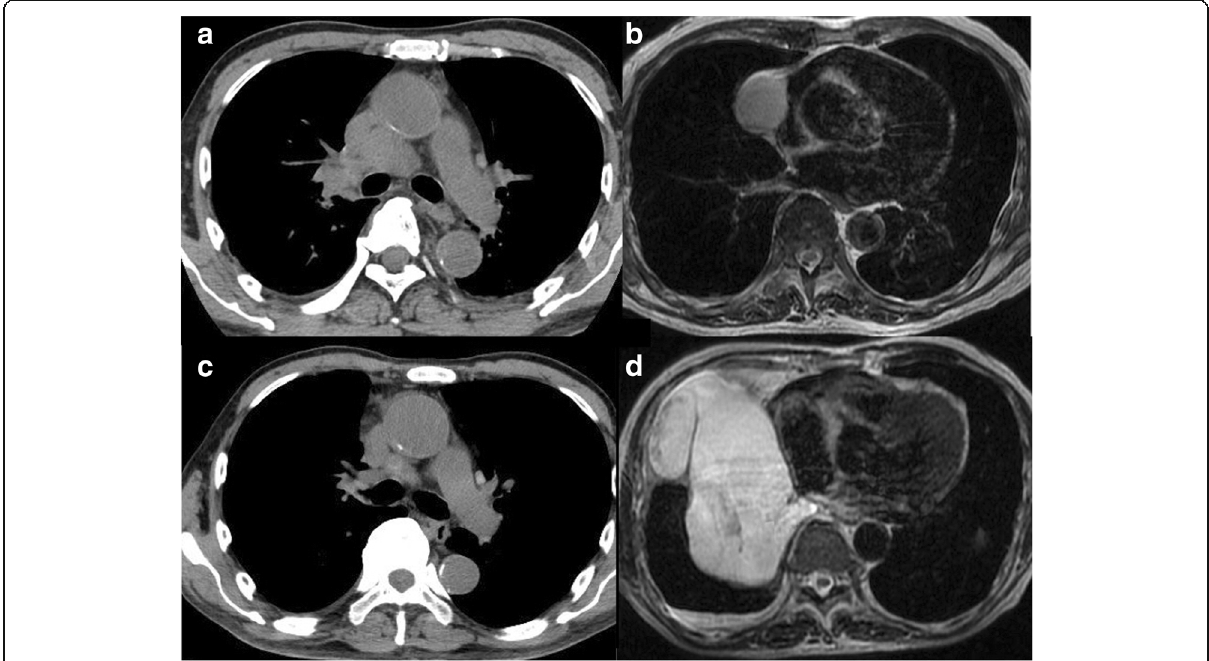
Fig. 1 Computed tomography revealed hilar and mediastinal lymph node enlargement ( a ). Magnetic resonance imaging demonstrated a high- intensity anterior mediastinal tumor on T2-weighted images ( b ). Treatment with pembrolizumab yielded a partial response from the non-small cell lung cancer (NSCLC) ( c ) but the mediastinal cyst enlarged extremely rapidly within 3 months ( d )